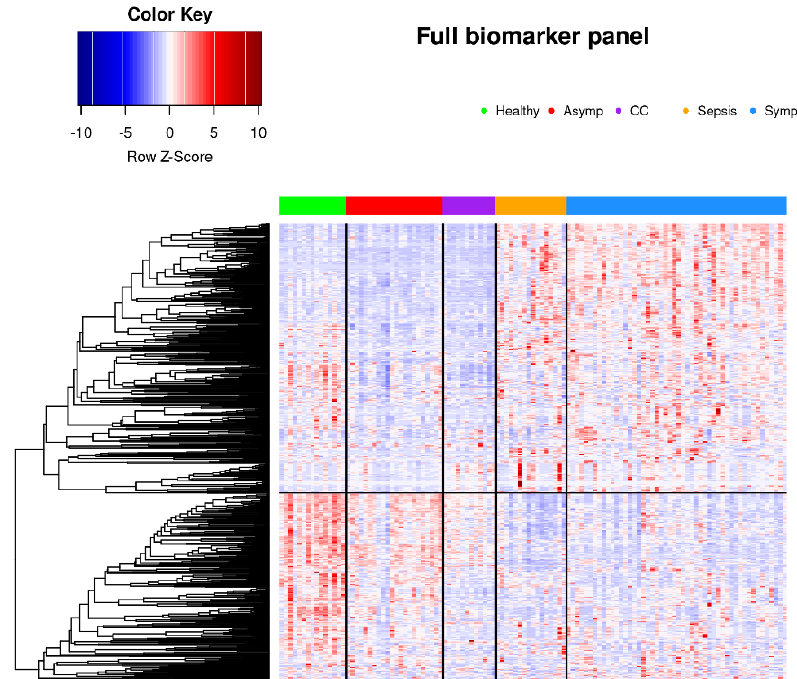
Figure 4. Heatmap in which all 115 patients and 597 biomarkers are represented, clustered into phenotype groups column-wise and hierarchically clustered row-wise. Row-wise Z-scores determine the color of each cell.